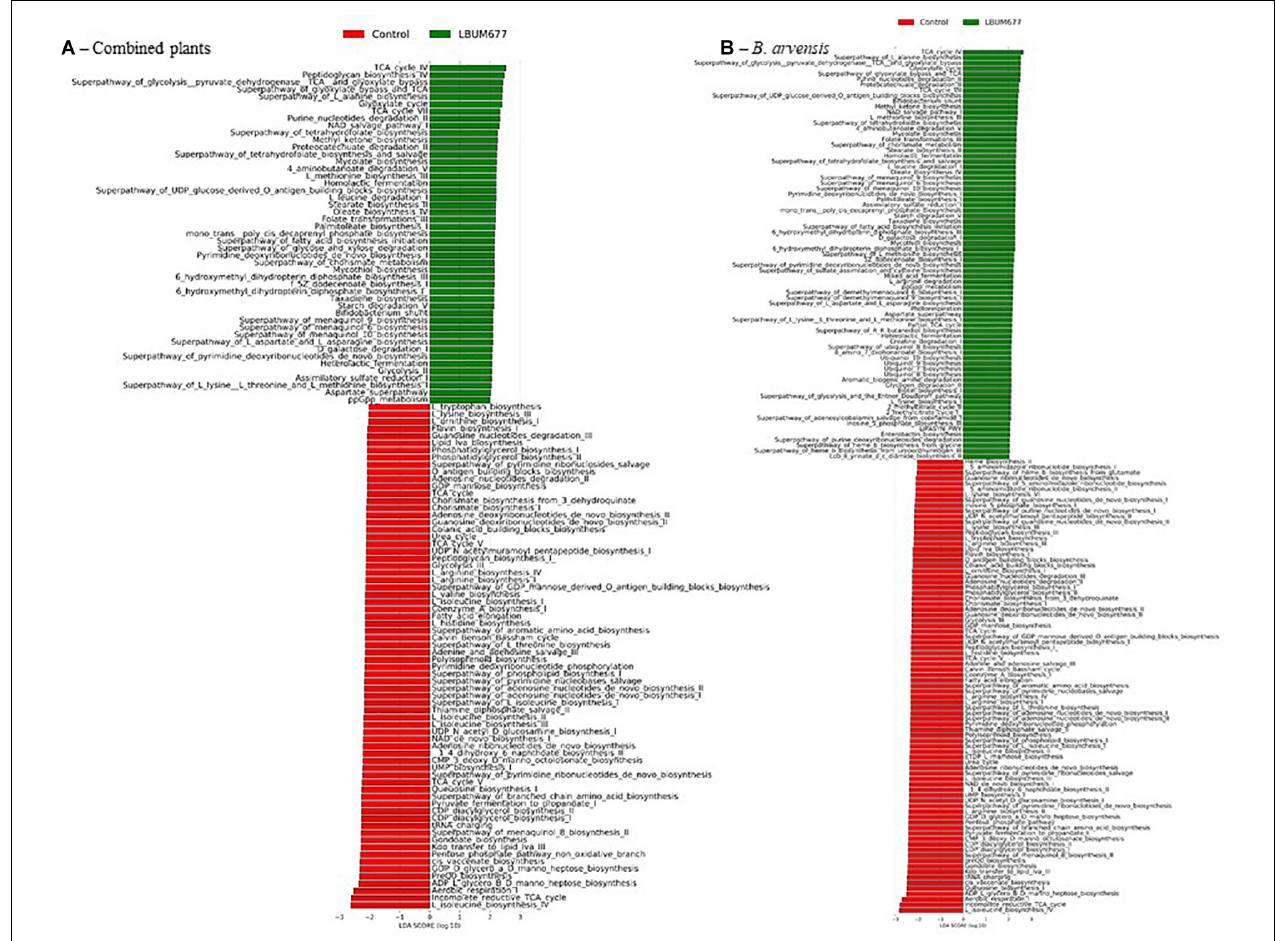
FIGURE 9 | Histogram of the LDA scores computed for differentially abundant MetaCyc pathways in control samples and in LBUM677-treated samples as determined using LEfSe. (A) the combination of all three plant species and (B) B. arvensis plants. Differentially abundant sequences were determined using the non-parametric factorial Kruskal-Wallis sum-rank test. A subsequent Linear Discriminant Analysis was used to estimate the effect size of each differentially abundant